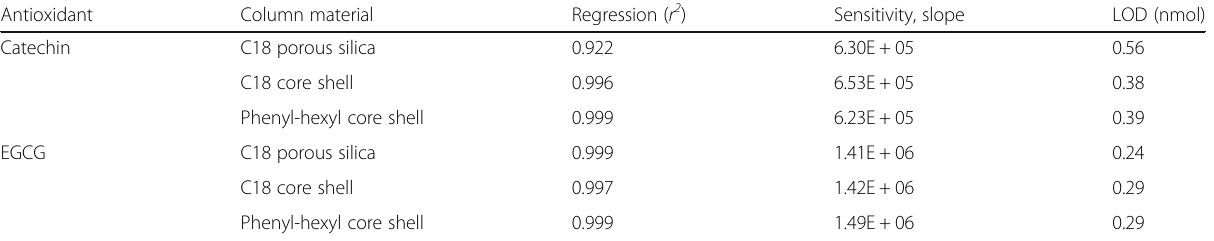
Table 2 Linear regression, sensitivity, and limits of detection using different